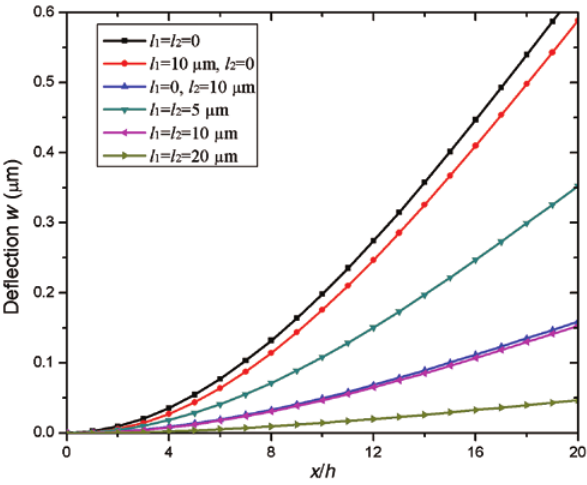
Figure 3: Variation of the deflection of piezoelectric beam along the beam with h = 20 μ m.